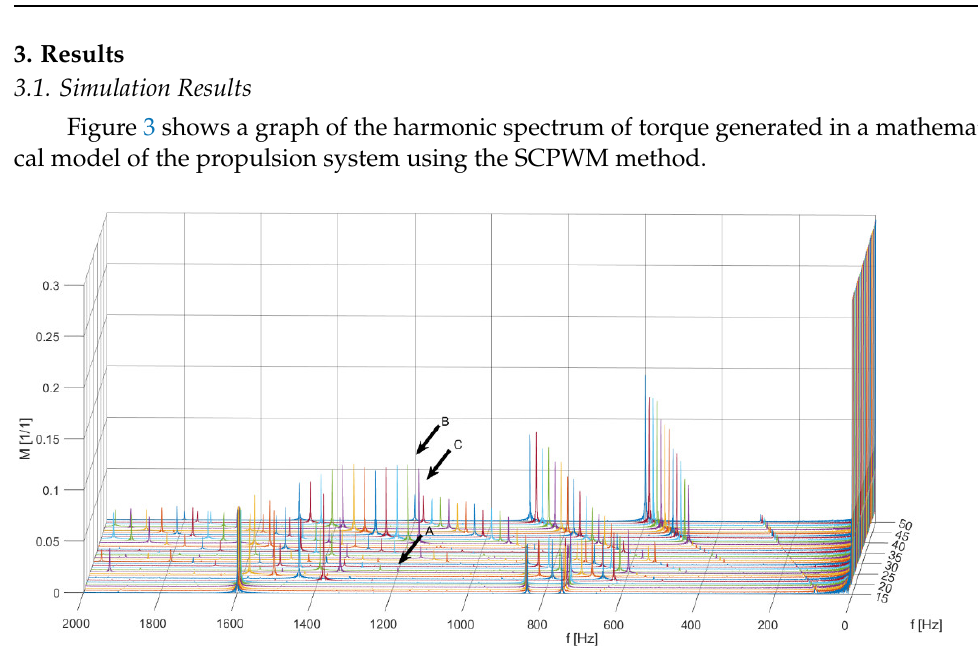
Figure 3. Relative values of the individual torque components depending on the frequency and fundamental frequency.